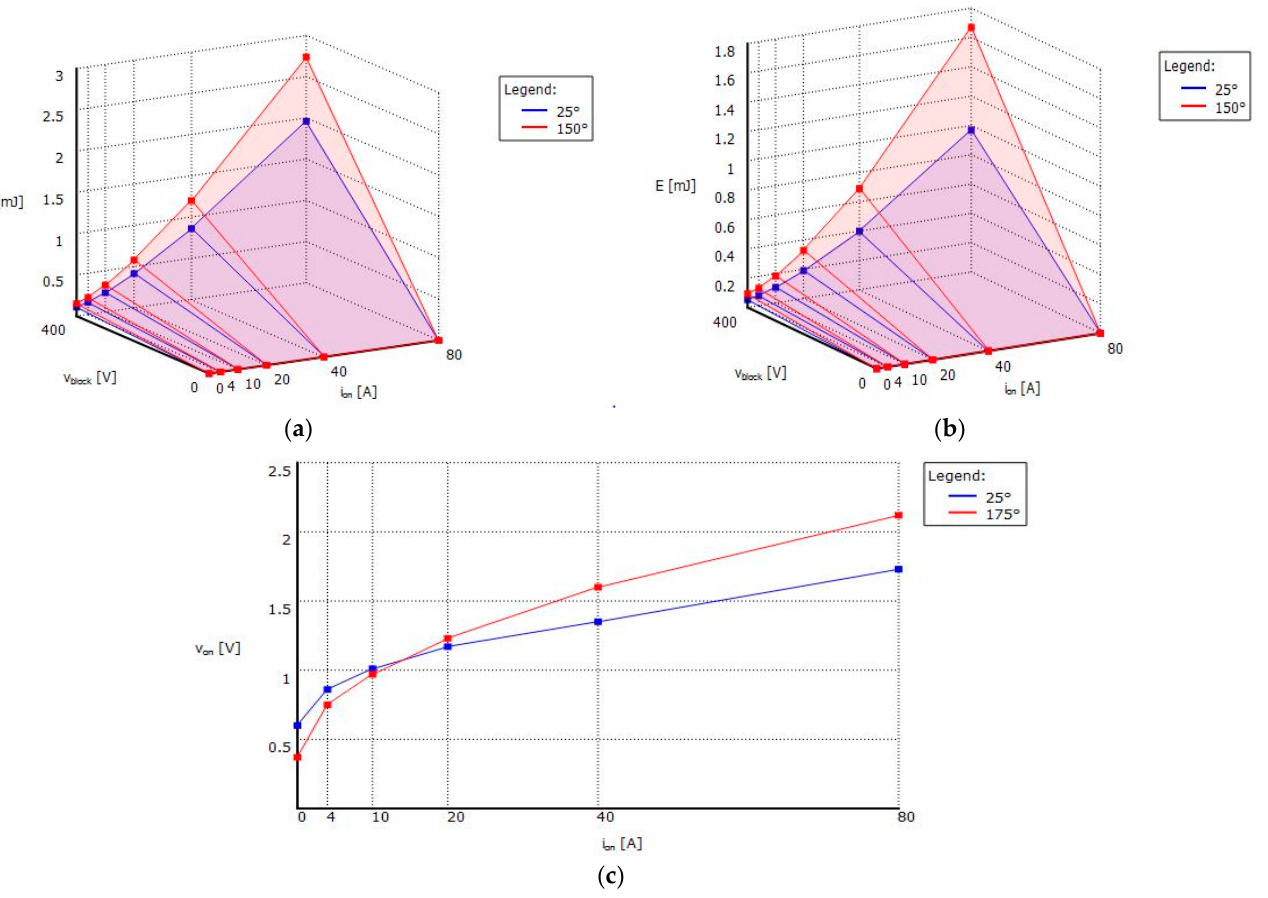
Figure 12. Loss model for ( a ) turn ON, ( b ) turn OFF, and ( c ) conduction loss for IGBT IGA30N60H3.